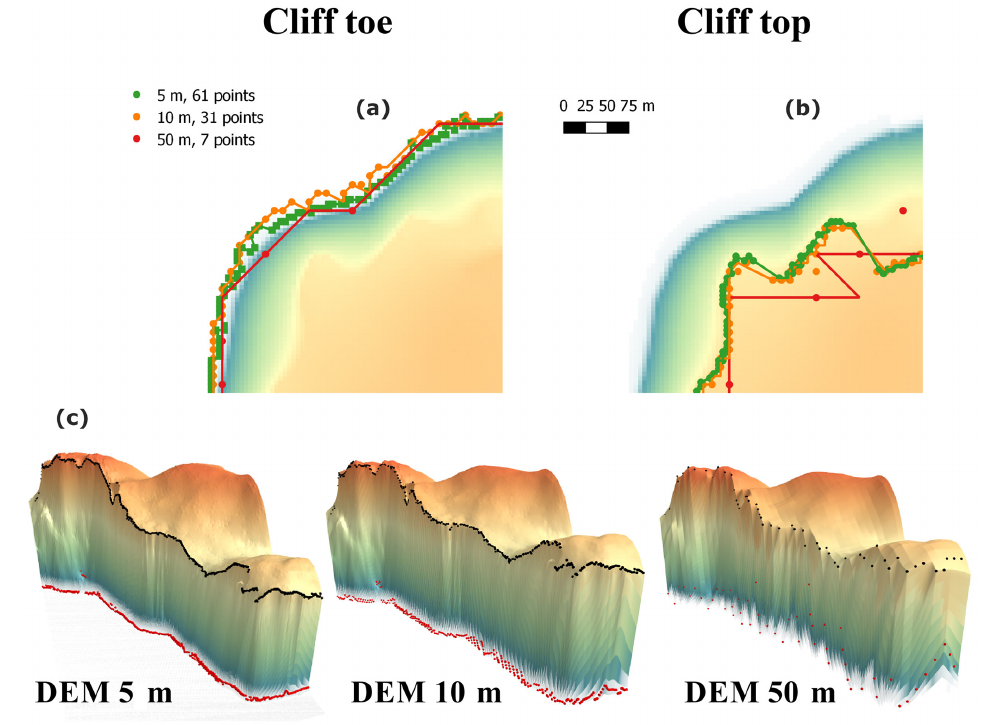
Figure 8. Cliff toe and top outputs for a high-cliffed coastline section and different DEM resolutions and smoothing window size. Upper panels show the locations of the cliff toe (a) and cliff top (b) . Bottom panels show 3-D models with the cliff toe and top as red and black spheres, respectively. Vertical dimension of 3-D models have been exaggerated 10